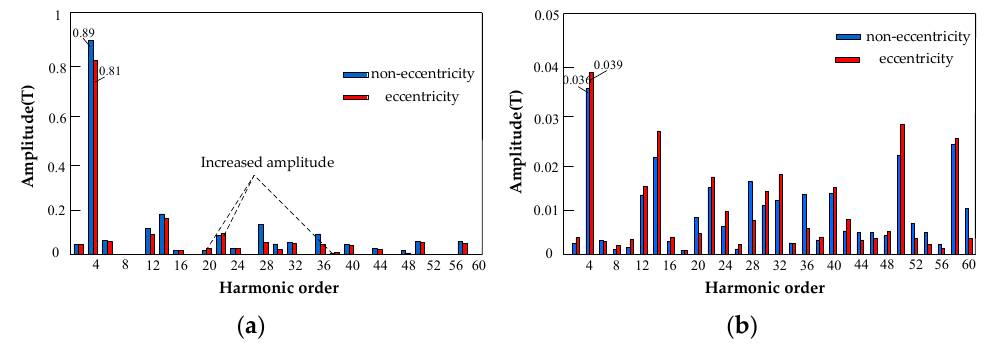
Figure 9. Harmonic distribution of radial and tangential air-gap magnetic density: ( a ) the amplitude of the radial air-gap magnetic density; ( b ) the amplitude of the tangential air-gap magnetic density.